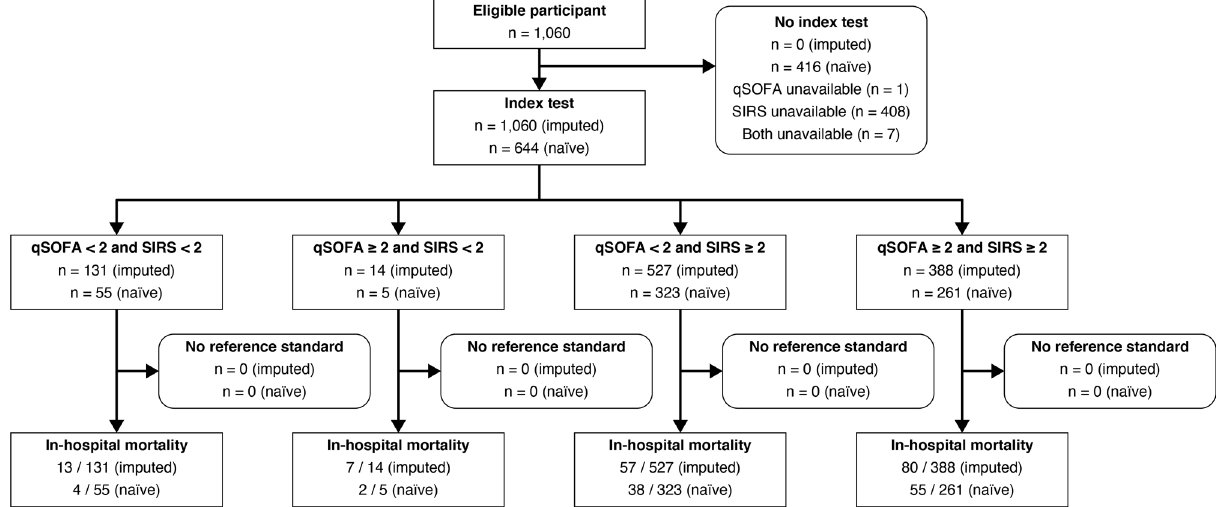
Figure 1. Participant selection tree. All participants recruited in the current study were divided into four groups according to the positivity of the tested scores. The multiply imputed study population and naïve (not imputed) population were included in the primary analysis and sensitivity analysis, respectively. qSOFA quick sequential organ failure assessment, SIRS systemic inflammatory response syndrome.